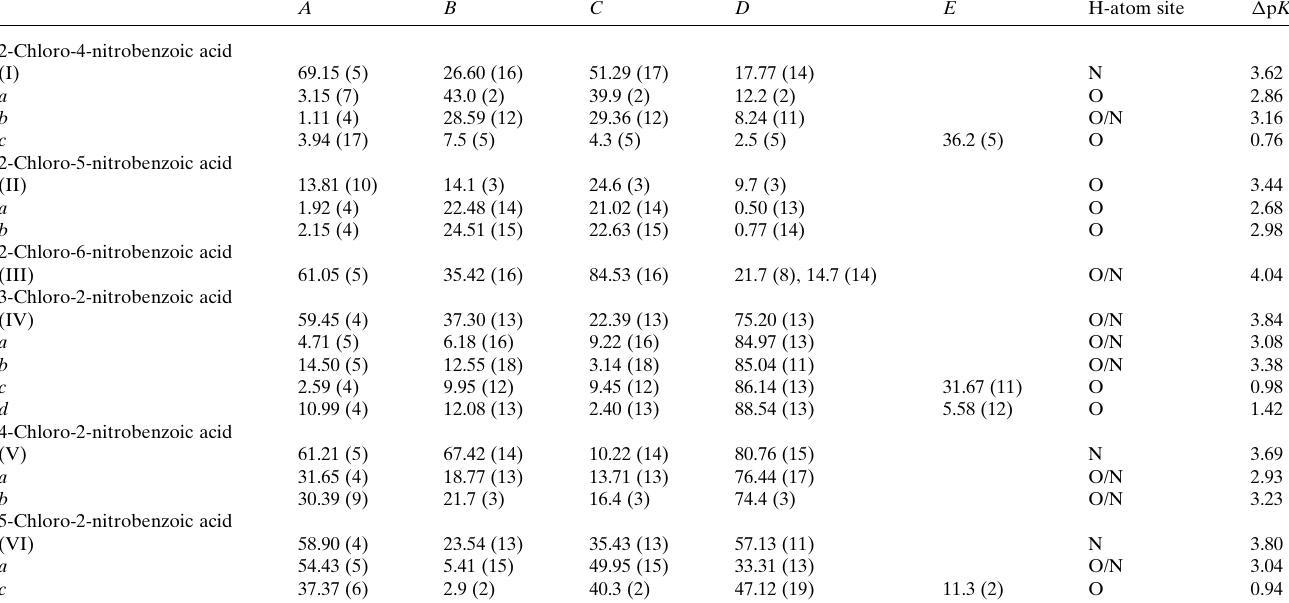
Table 1 Dihedral angles in the acid-base unit ( (cid:4) ), hydrogen position and (cid:2) p K a . A , B , C , D and E are the dihedral angles between the C1–C6 ring and the N2/C8–C16 ring system, between the O1/C7/O2 plane and the N2/C8–C16 ring system, between the C1–C6 ring and the O1/C7/O2 plane, between the C1–C6 ring and the O3/N1/O4 plane, and between the N2/C8–C16 ring system and the nitro group attached to it, respectively.